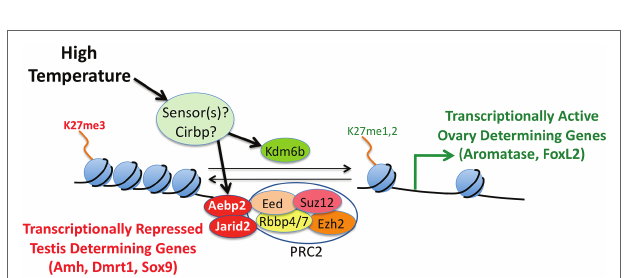
FIGURE 5 | A conceptual model of the molecular mechanisms underlying temperature-dependent sex determination. Hypothetical temperature sensors influence expression and/or splicing of epigenetic regulators like Jarid2, Aebp2, and Kdm6b. In turn, these proteins influence methylation levels of histone H3 on lysine 27. Tri-methylation of H3K27 results in silencing of target genes, while mono- or di-methylation of H3K27 results in activation of target